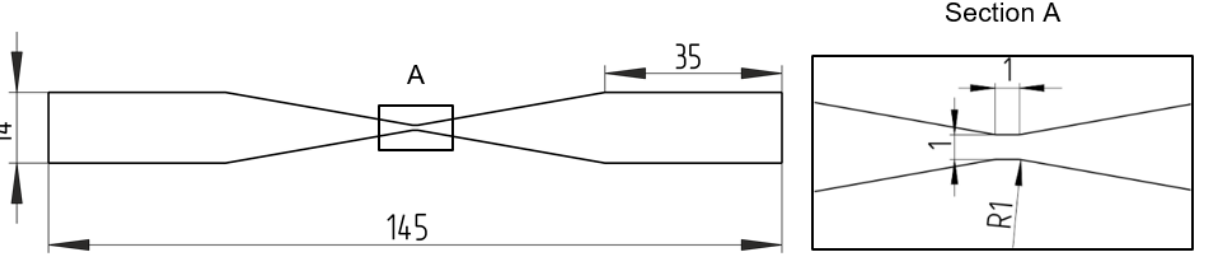
Figure 2. Specimen geometry for pre-deformation and µCT examinations made of 2 mm thick AISI 304 steel sheet with given dimensions in mm. Test region is shown magnified.